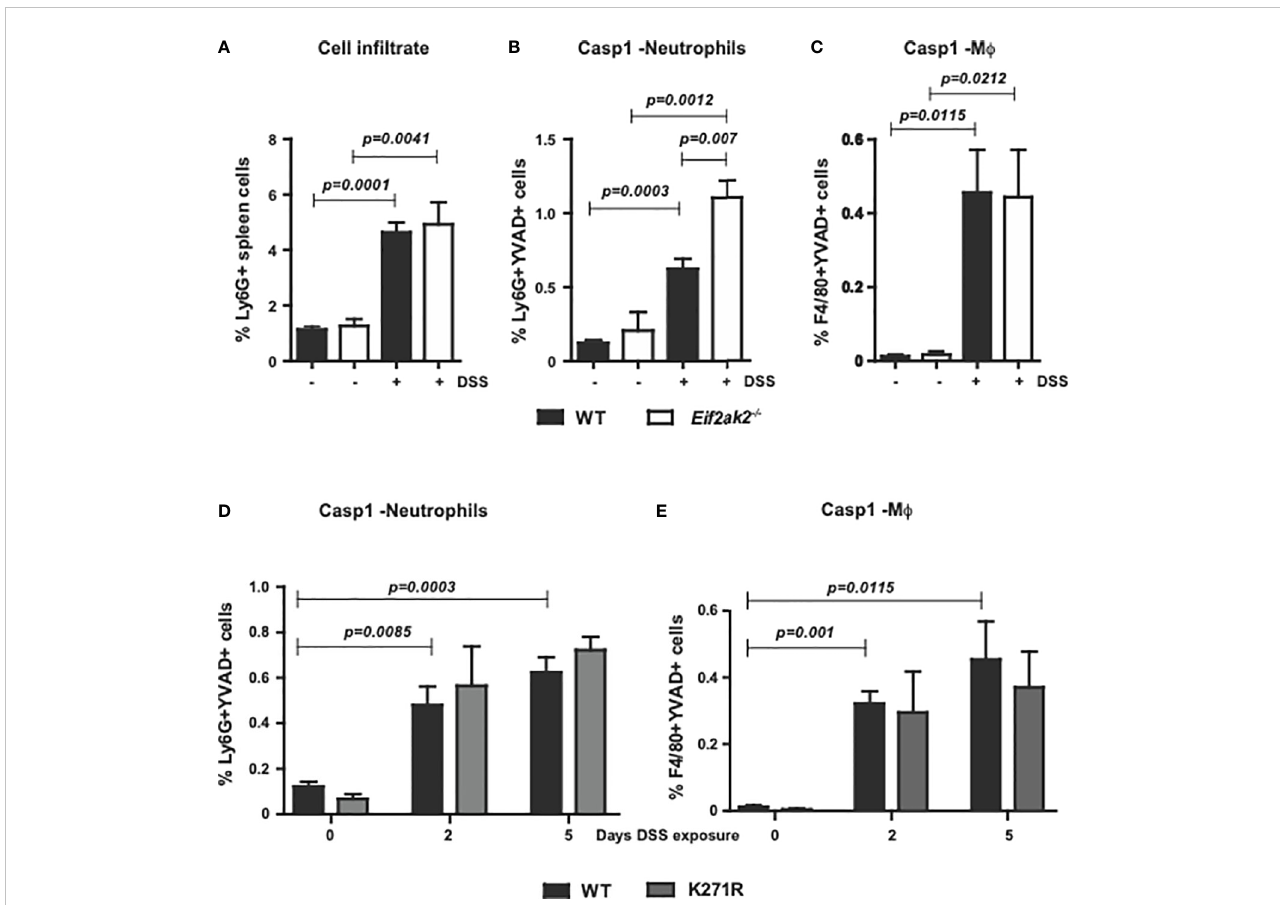
FIGURE 4 PKR limits in fl ammasome activity in splenic neutrophils. (A) Detection of Ly6G + in fl ammatory cells in the spleens of WT compared to PKR-ablated ( Eif2ak2 -/- ) mice either untreated or treated with DSS for fi ve days. (B – E) Measures of Casp1 activity (YVAD+), quanti fi ed by fl ow cytometry in splenic neutrophils (Ly6G + +YVAD + ) and macrophages (M f , F4/80 + +YVAD + ) from (B, C) the WT compared to PKR-ablated mice after 5 days of DSS treatment (H 2 O, n=4 and DSS, n=5) and (D, E) WT compared to PKR-K271R kinase-dead mice assessed after the indicated day of DSS treatment (n=6). Data are expressed as mean ± S.E.M. and analyzed by two-way ANOVA with S ̌ idàk